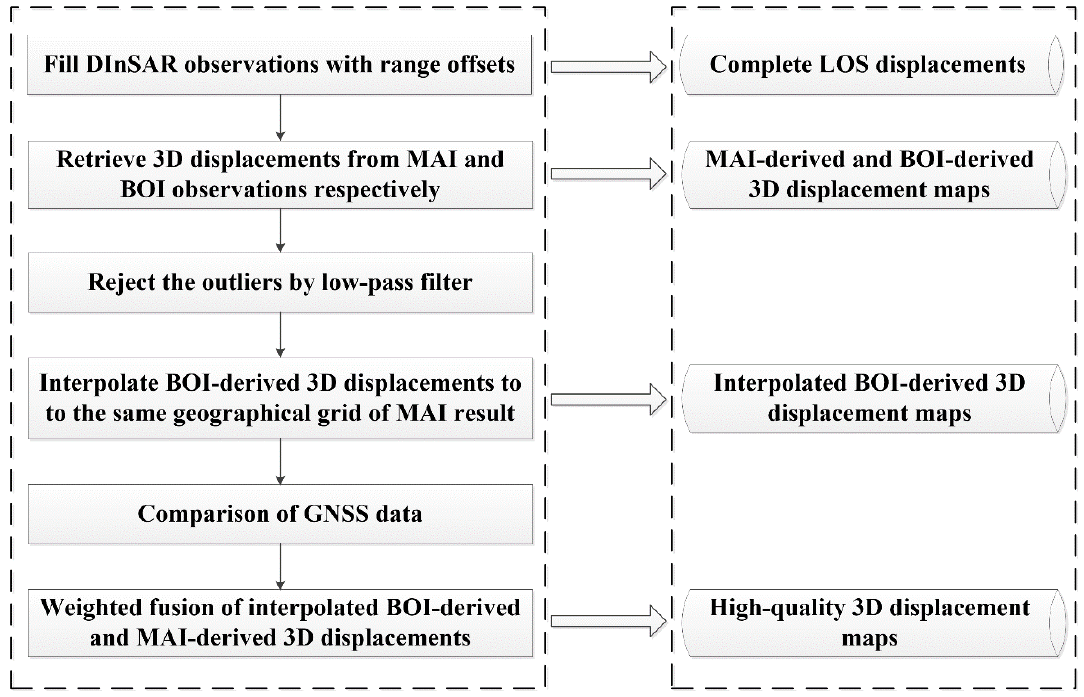
Figure 5. Flowchart illustrating the process of retrieving high-quality 3D displacement maps based on the integration approach.